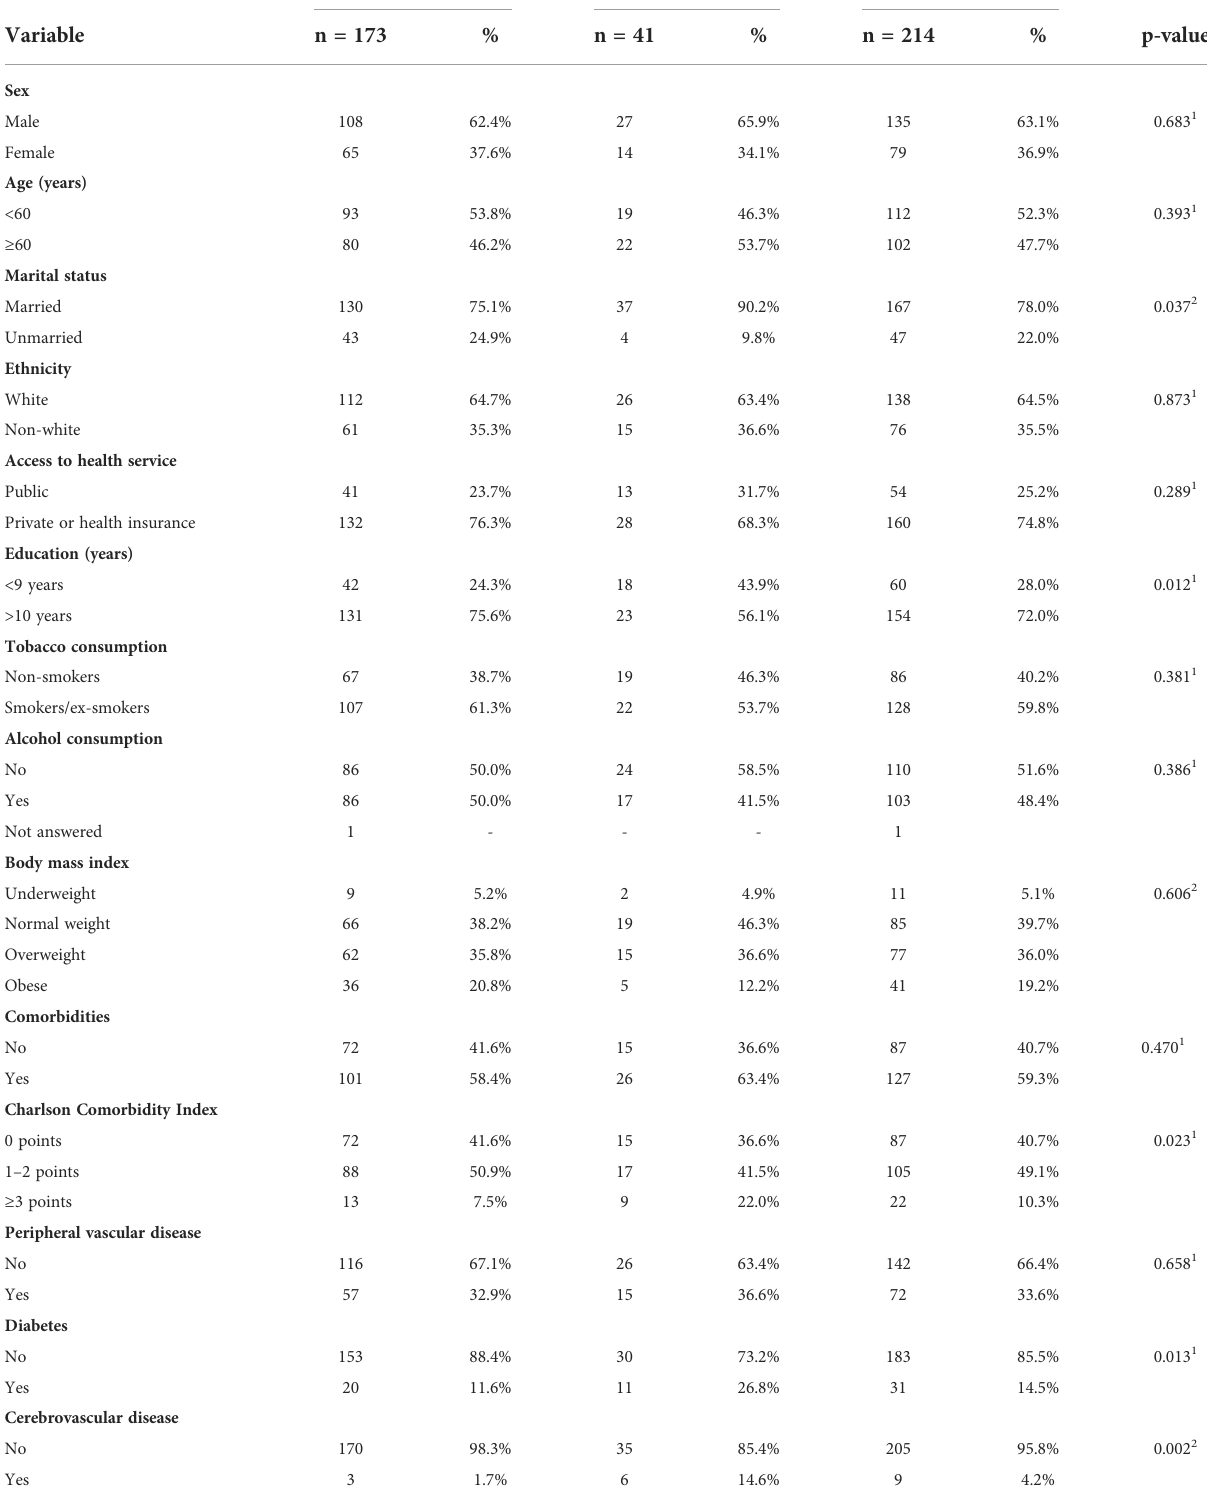
TABLE 1 Sociodemographic, lifestyle, and clinical characteristics of 214 patients with gastric adenocarcinoma according to vital status at 1-year follow-up. Alive Deaths Total Variable n =